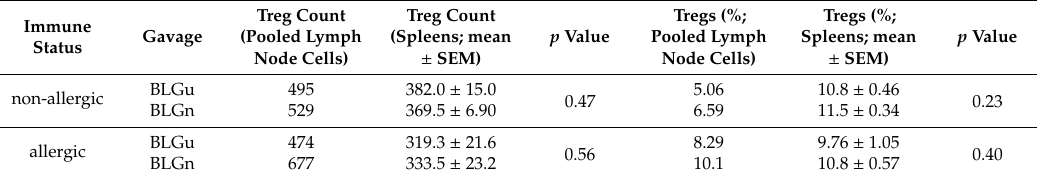
Table 2. Relative and absolute Treg counts from spleens and pooled lymph node cells of non-allergic or allergic animals after gavages of BLGu or